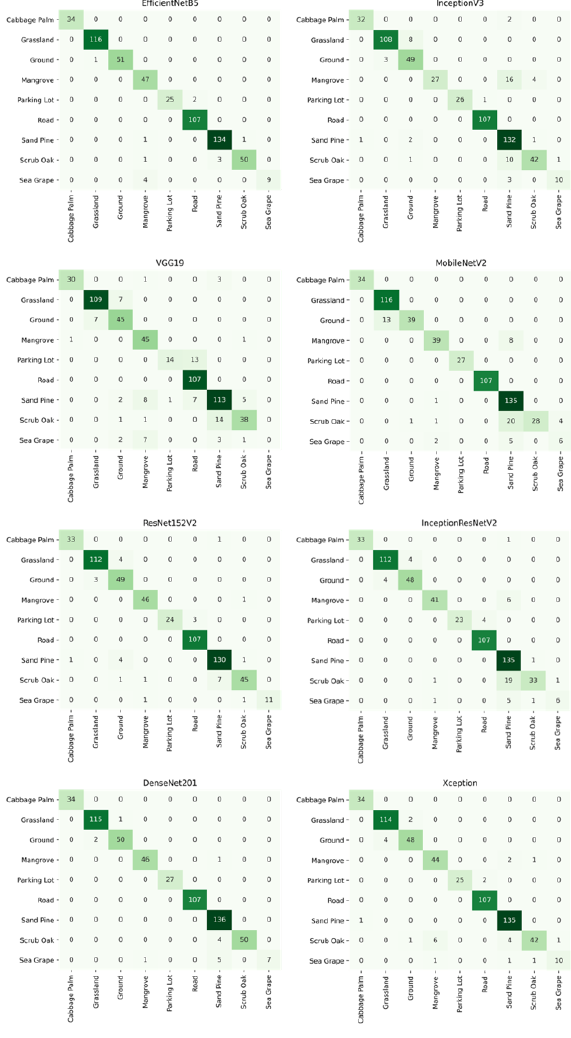
Figure 6: Confusion matrices for scene